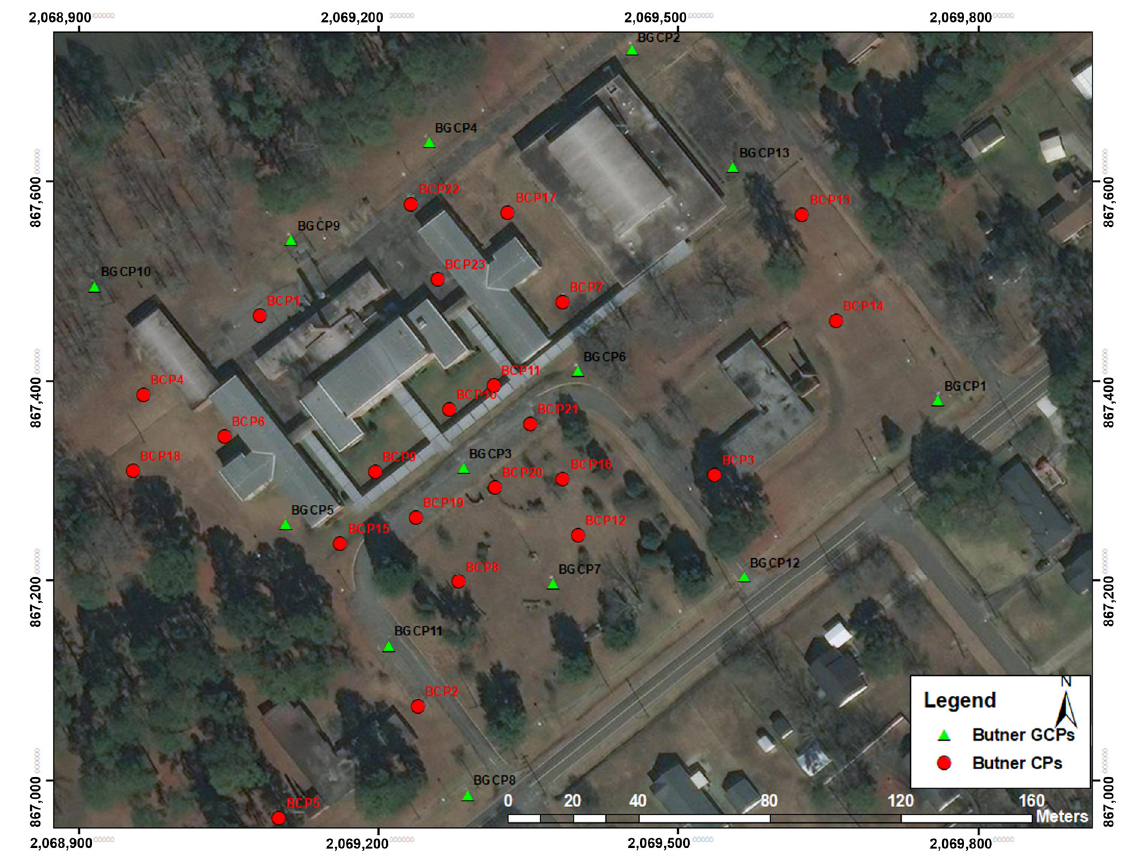
Figure 8. Layout of GCPs and CPs in NCDOT UAS test